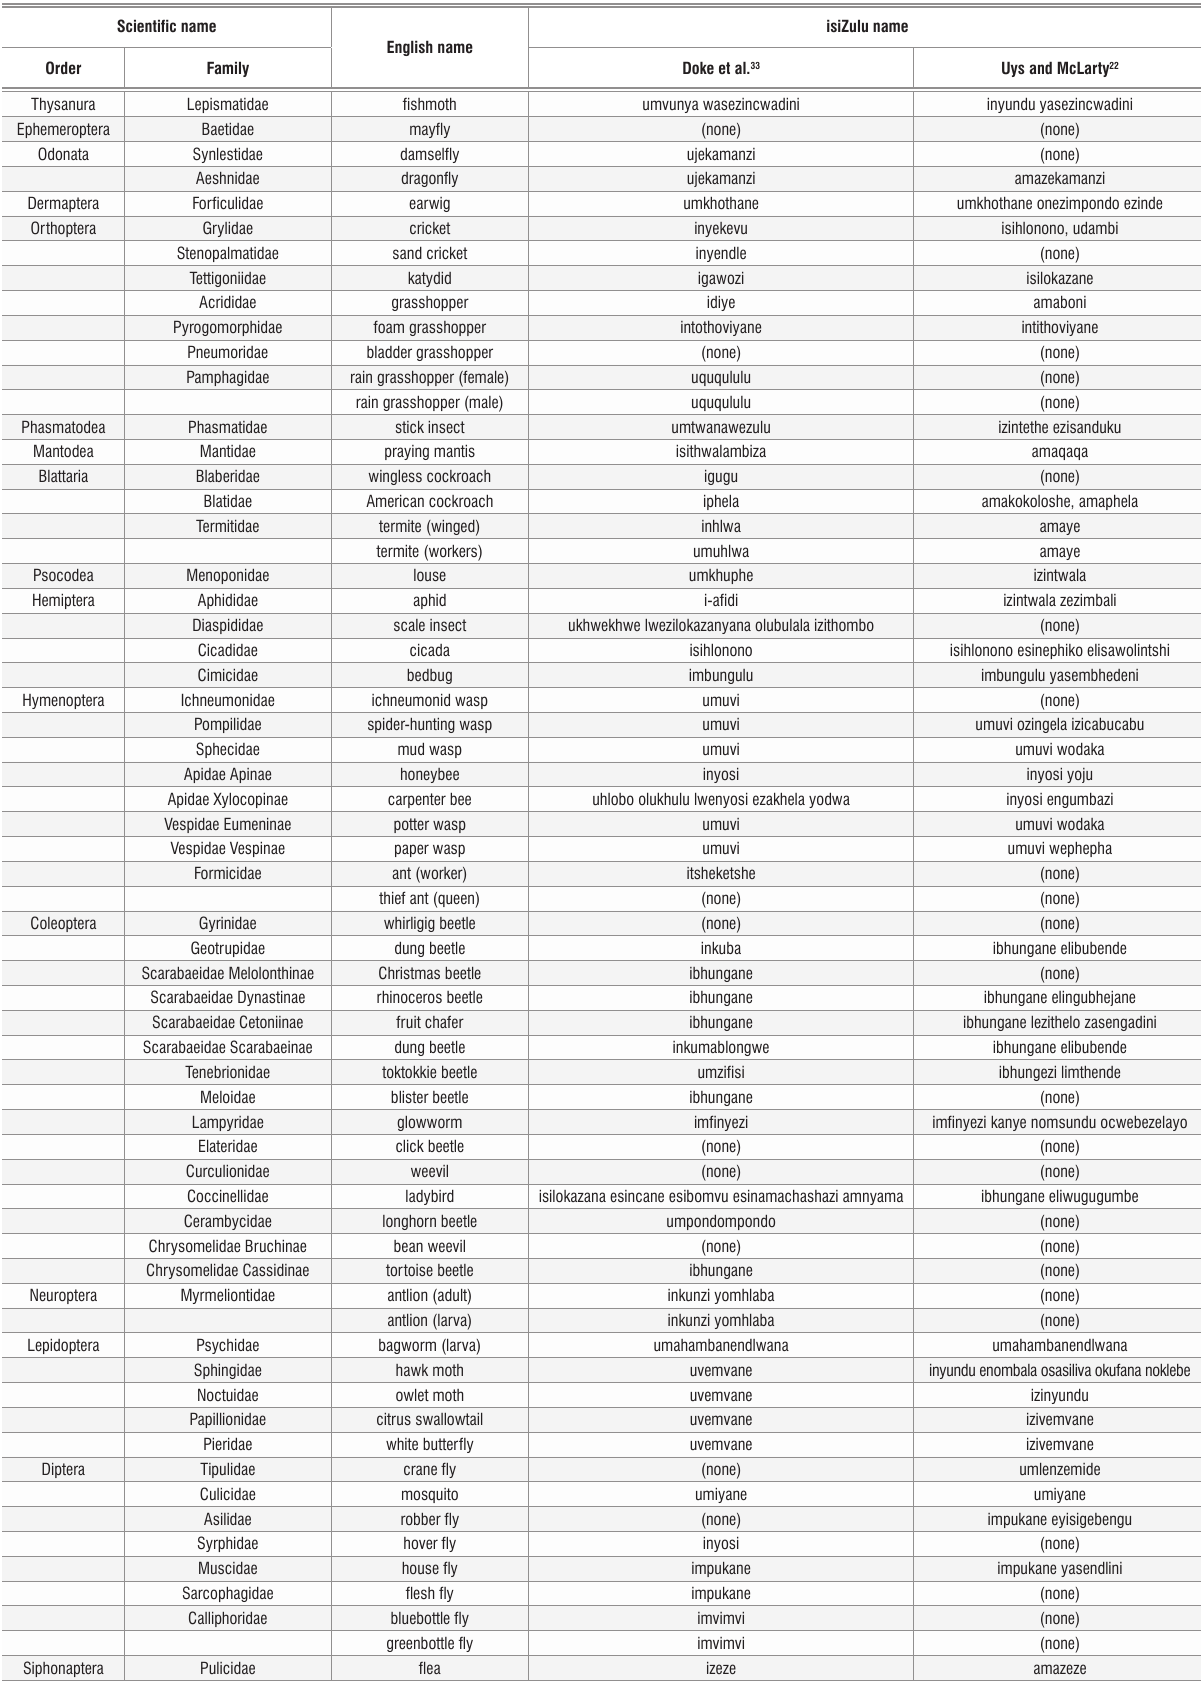
Table 1: List of insect specimens used in interviews, and of names listed by Doke et al. 33 and Uys and McLarty 22 . The names are sorted phylogenetically so that entomologists can assess the taxonomic